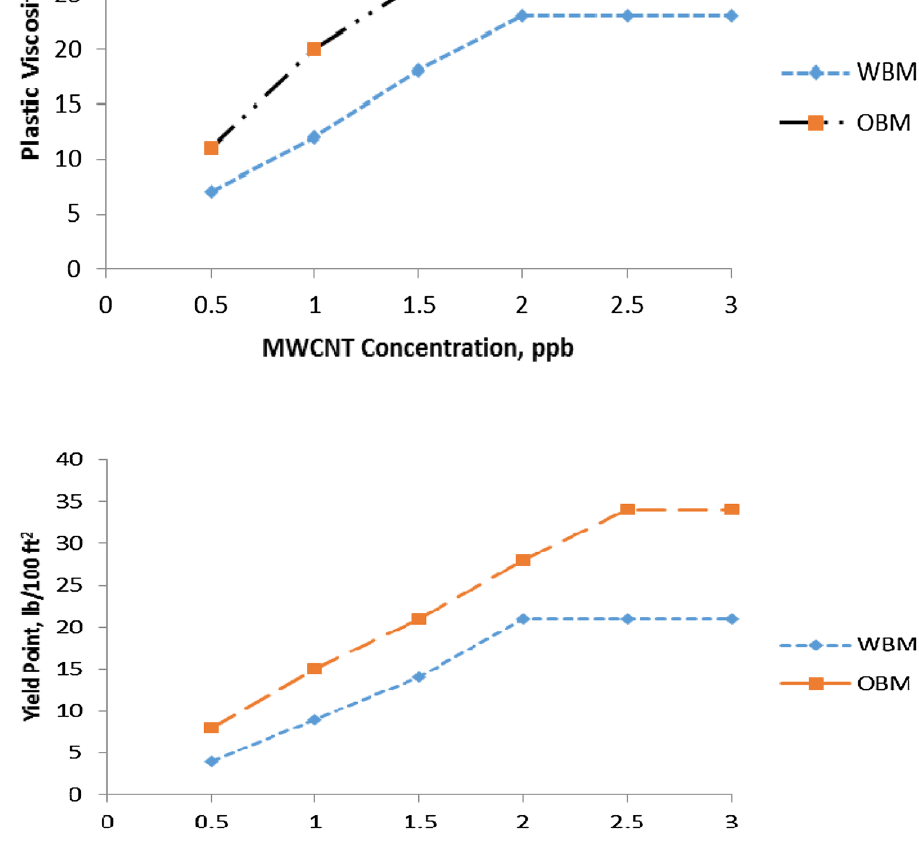
Fig. 2 Plastic viscosities at different concentrations of MWCNT for WBM and OBM